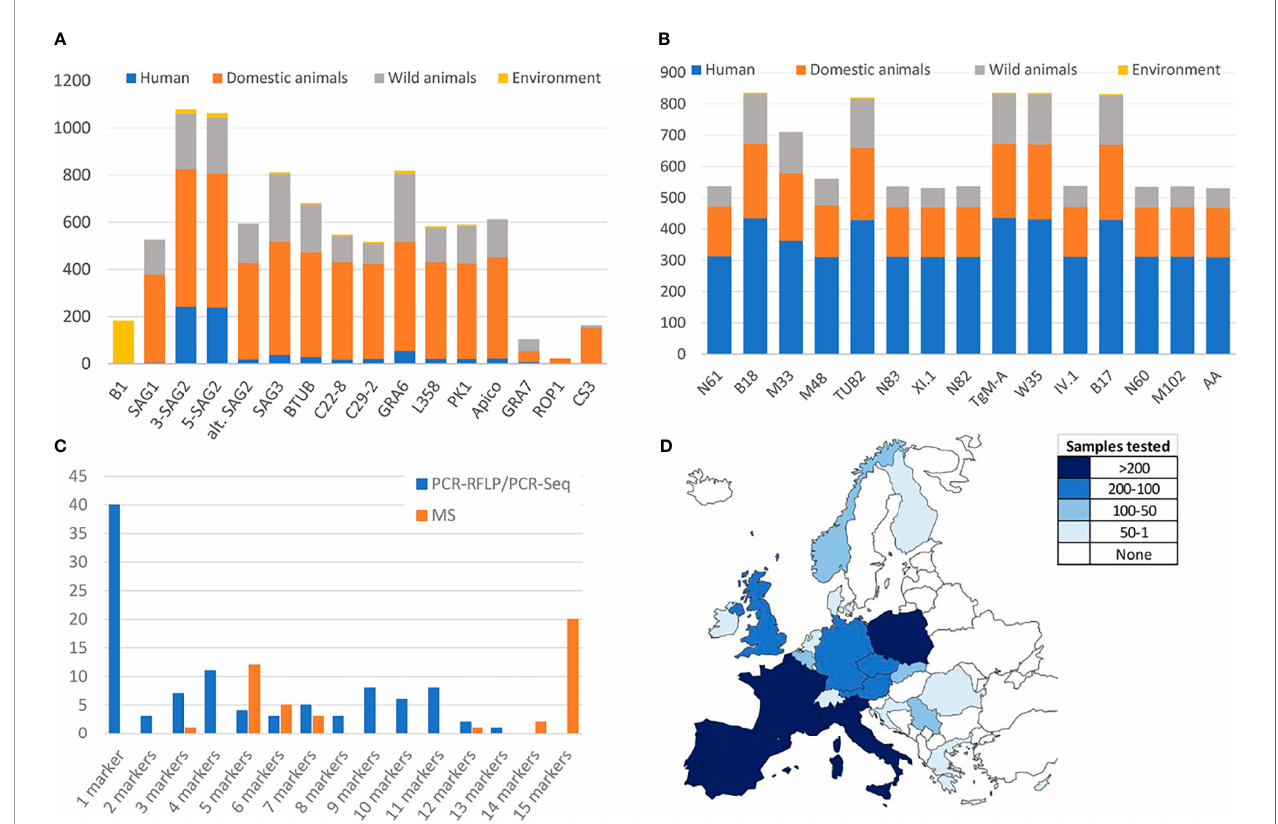
FIGURE 2 | Analyses of the methodologies used within European Toxoplasma gondii genotyping studies. (A) Number of samples typed by each PCR-RFLP marker in genotyping European studies. (B) Number of samples typed by each MS marker in genotyping European studies. (C) Proportion of studies implementing different number of PCR-RFLP/PCR-Seq or MS genotyping markers. (D) Geographic distribution of genotyped samples across Europe. Only studies meeting the cut-off criterion (at least 4 PCR-RFLP/PCR-Seq or 5 MS markers applied) have been